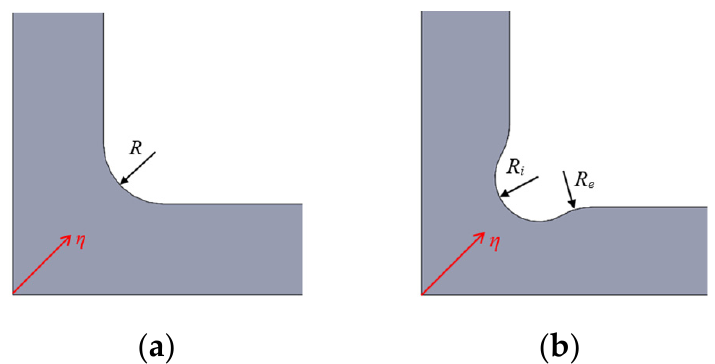
Figure 7. Fillet radii and stress paths in ( a ) geometry A and ( b ) geometry B.